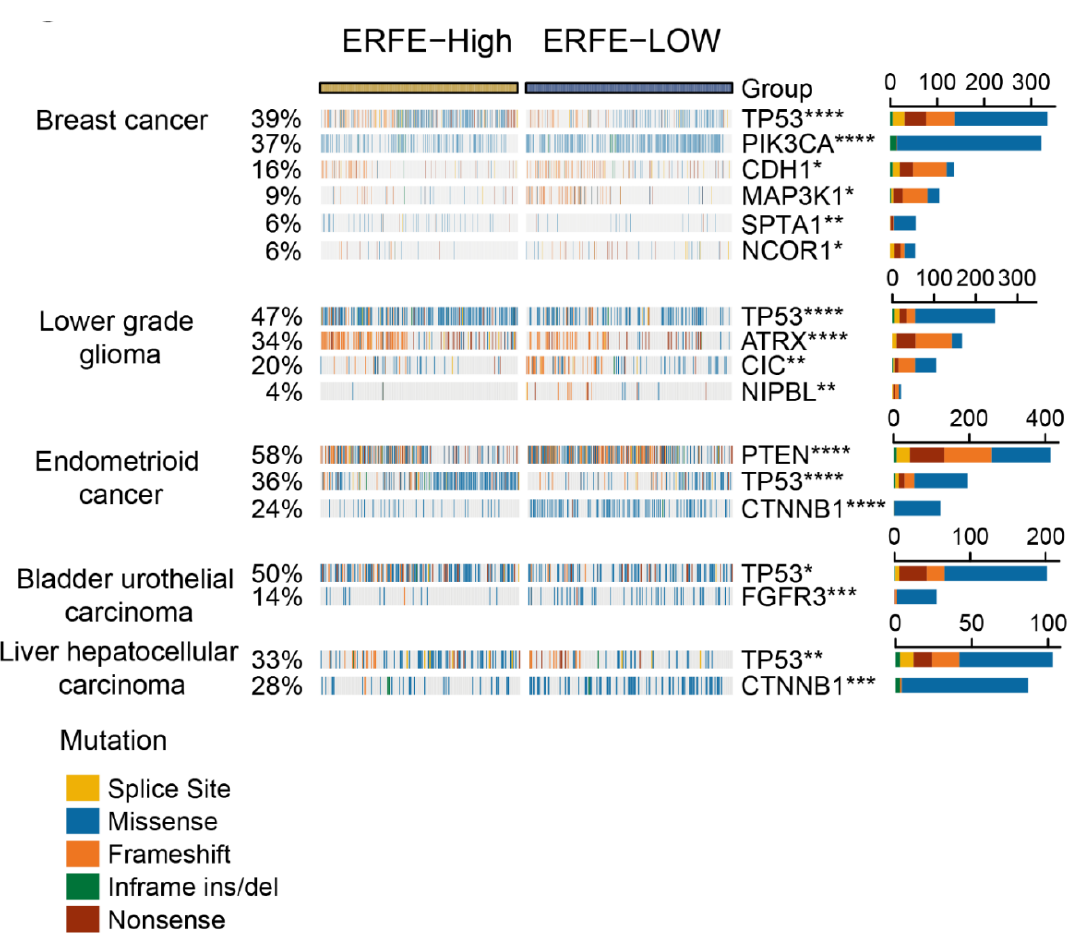
Figure 3. Correlation of ERFE expression status with genetic alterations. An oncoplot is presented for the top 20 frequently mutated genes significantly correlated with ERFE expression levels in pan-cancer. Fisher’s exact test was conducted and results with adjusted p < 0.05 are displayed. * p < 0.05; ** p < 0.01; *** p < 0.001; **** p < 0.0001.